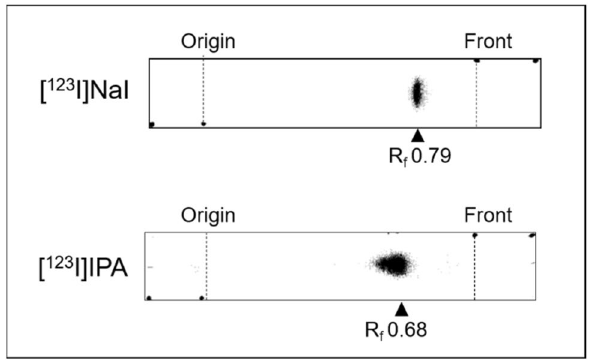
Figure 4. TLC profiles of [ 123 I]NaI and [ 123 I]IPA synthesized by the NBS method.